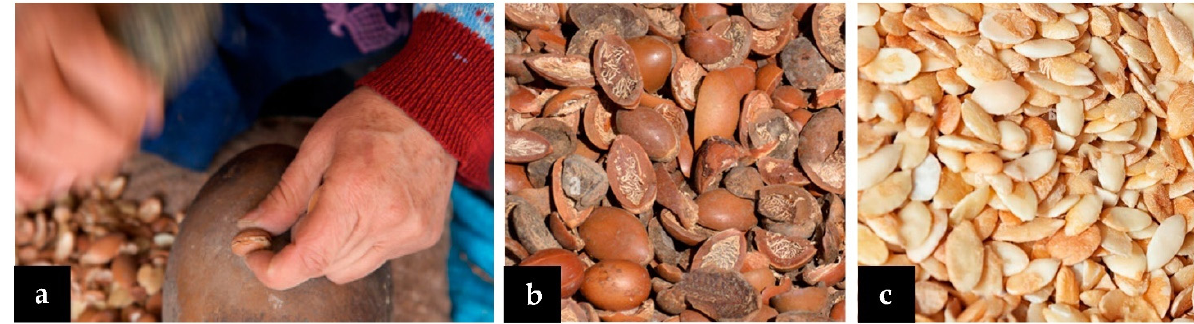
Figure 2. Manual extraction of kernel from the argan shells ( a ), fruit shells ( b ), and kernels ( c